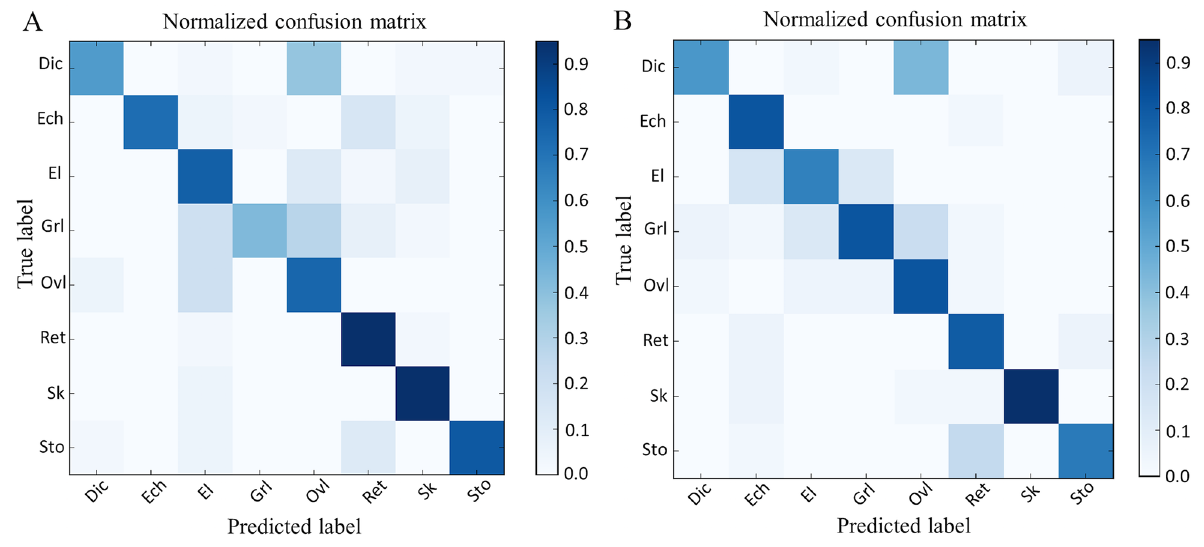
Fig 10. Normalized confusion matrix results with respectto different number of iterations. (A) max_iter = 30. (B) max_iter = 60.